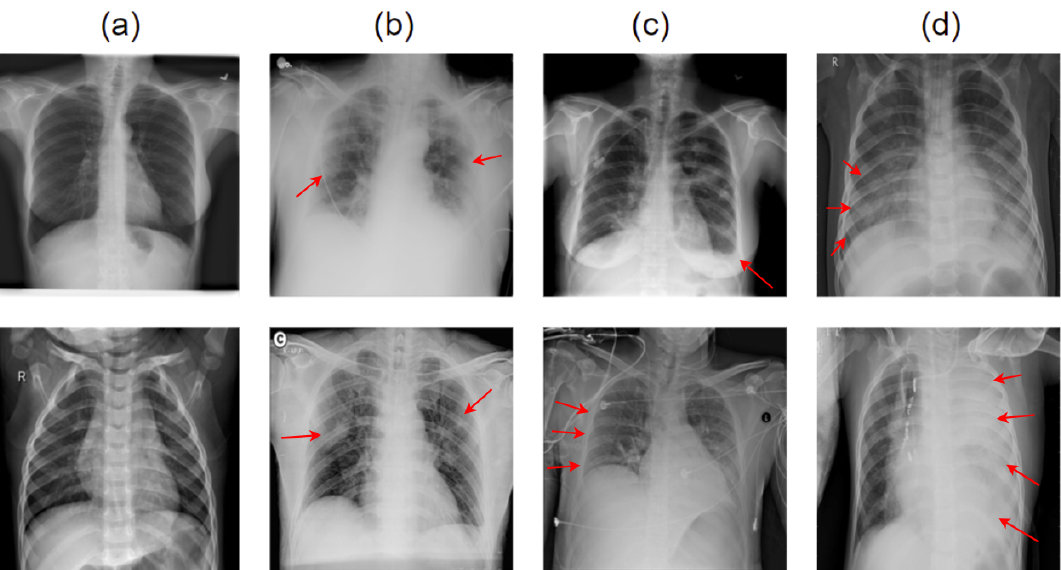
Figure 2. sample image data for multi class classification to detect ( a ) normal, ( b ) COVID-19, ( c ) lung opacity and ( d ) non-COVID viral pneumonia. Here, the red markers indicates the infected